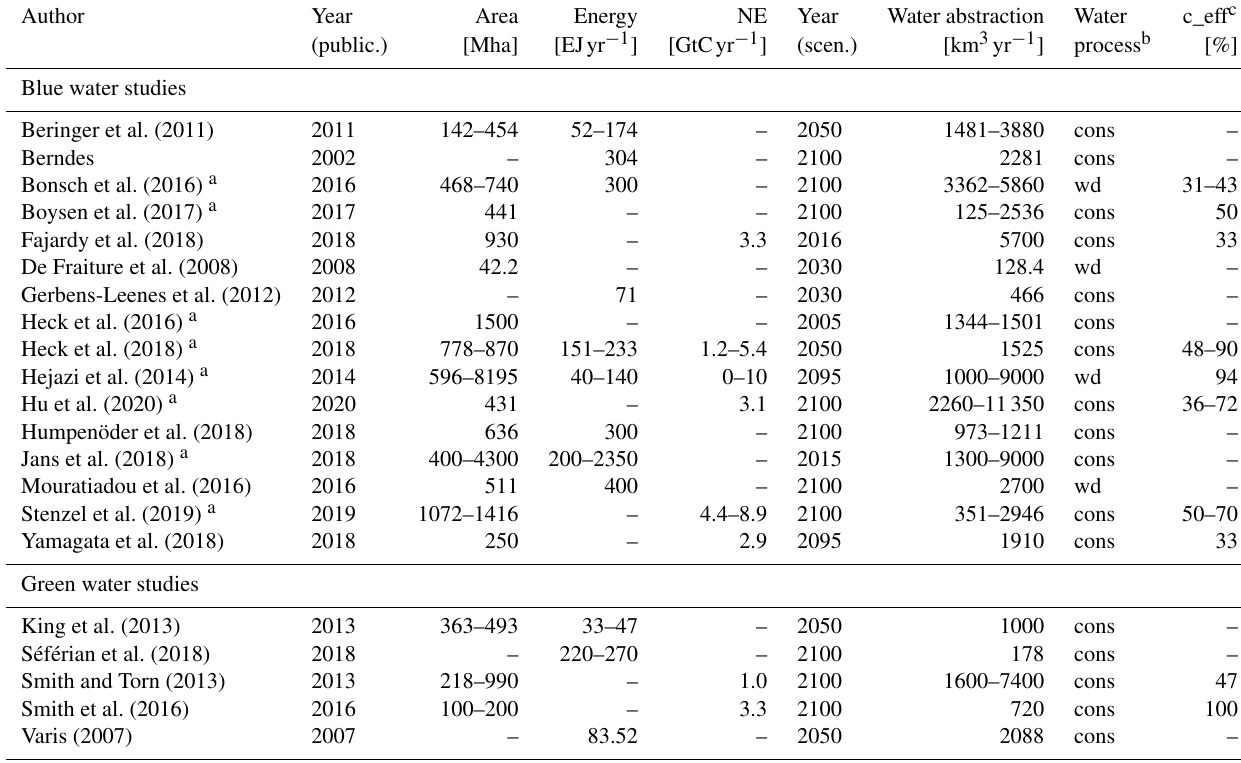
Table 1. List of publications with published key bioenergy parameters analysed in this review. See supplementary dataset (Stenzel et al., 2021) for additional parameters and all scenarios per